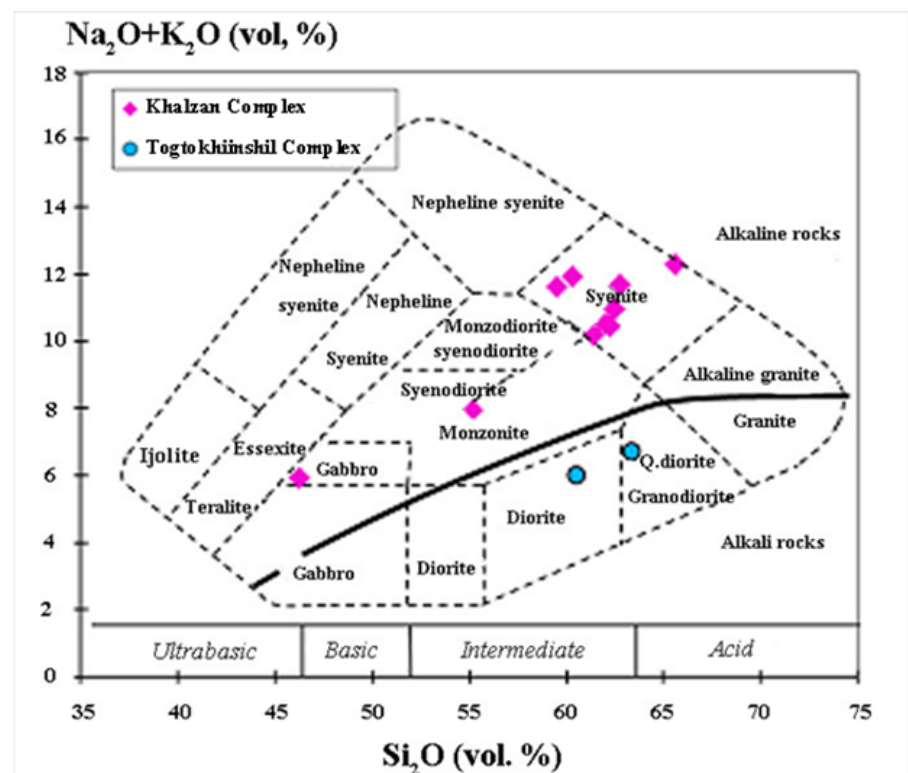
Fig. 10. TAS classification diagram (Le Maitre, 1989) for the Khalzan and Togtokhiinshil complex rocks in the Ulaan Del deposit